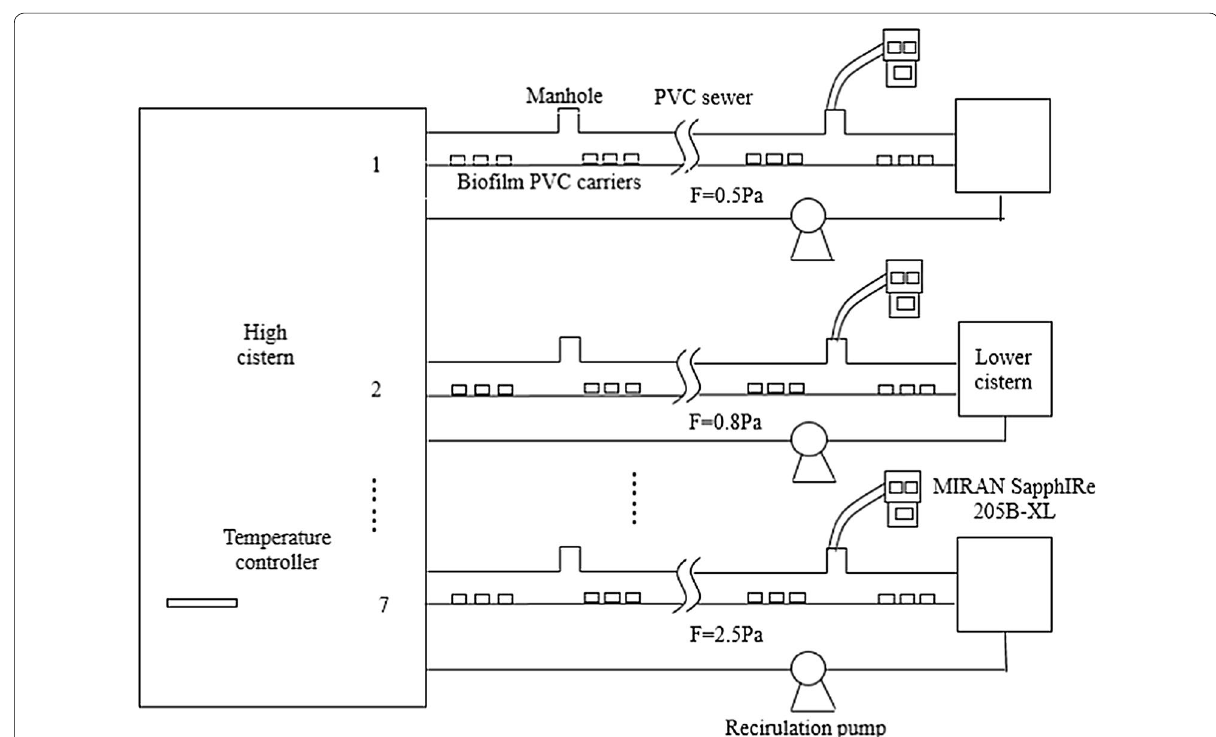
Fig. 1 Layout of the pilot gravitational sewers and the sectional view. A well-controlled pilot system was set up to simulate the practical opera- tion of sewers. Seven PVC (Poly Vinyl Chloride) sewers with identical size (with 8.0 m length, 57.0 mm inner diameter and I operated in parallel under the wall-shear stresses of 0.5, 0.8, 1.12, 1.29, 1.45, 2.0 and 2.5 Pa. Synthetic sewage that added into the seven sewers was prepared in an elevated PVC tank (20.0 L) with the water temperature maintained in the range of 20.0–25.0 °C, which was similar to